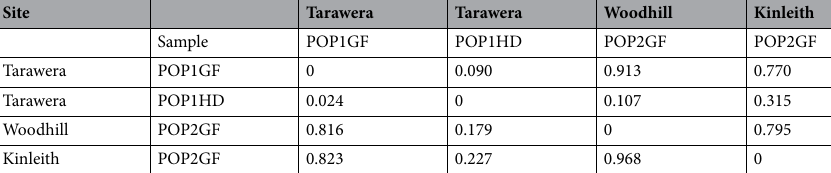
Table 3. Krzanowski correlations of marker-based (below diagonal) and pedigree-based (above diagonal) additive genetic variance-covariance matrices between samples.